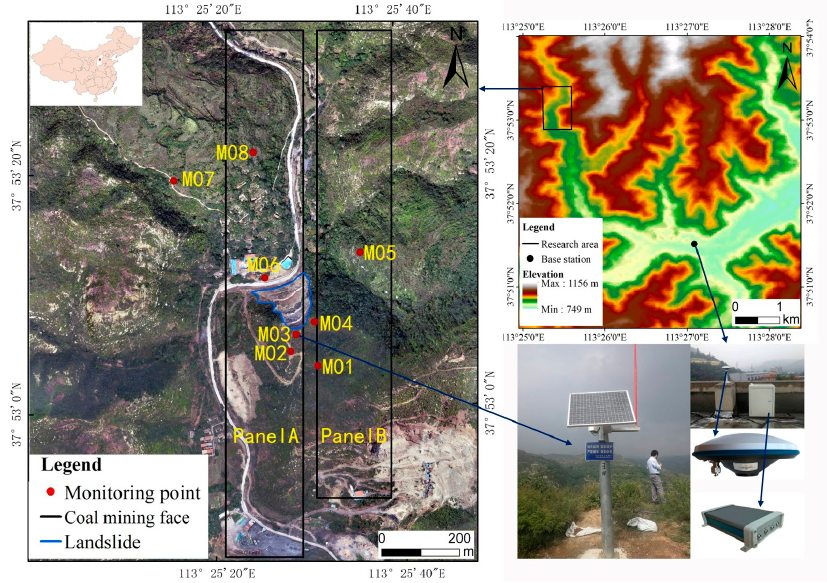
Figure 1. Overview of the study area and distribution of Global Navigation Satellite System (GNSS) monitoring points.